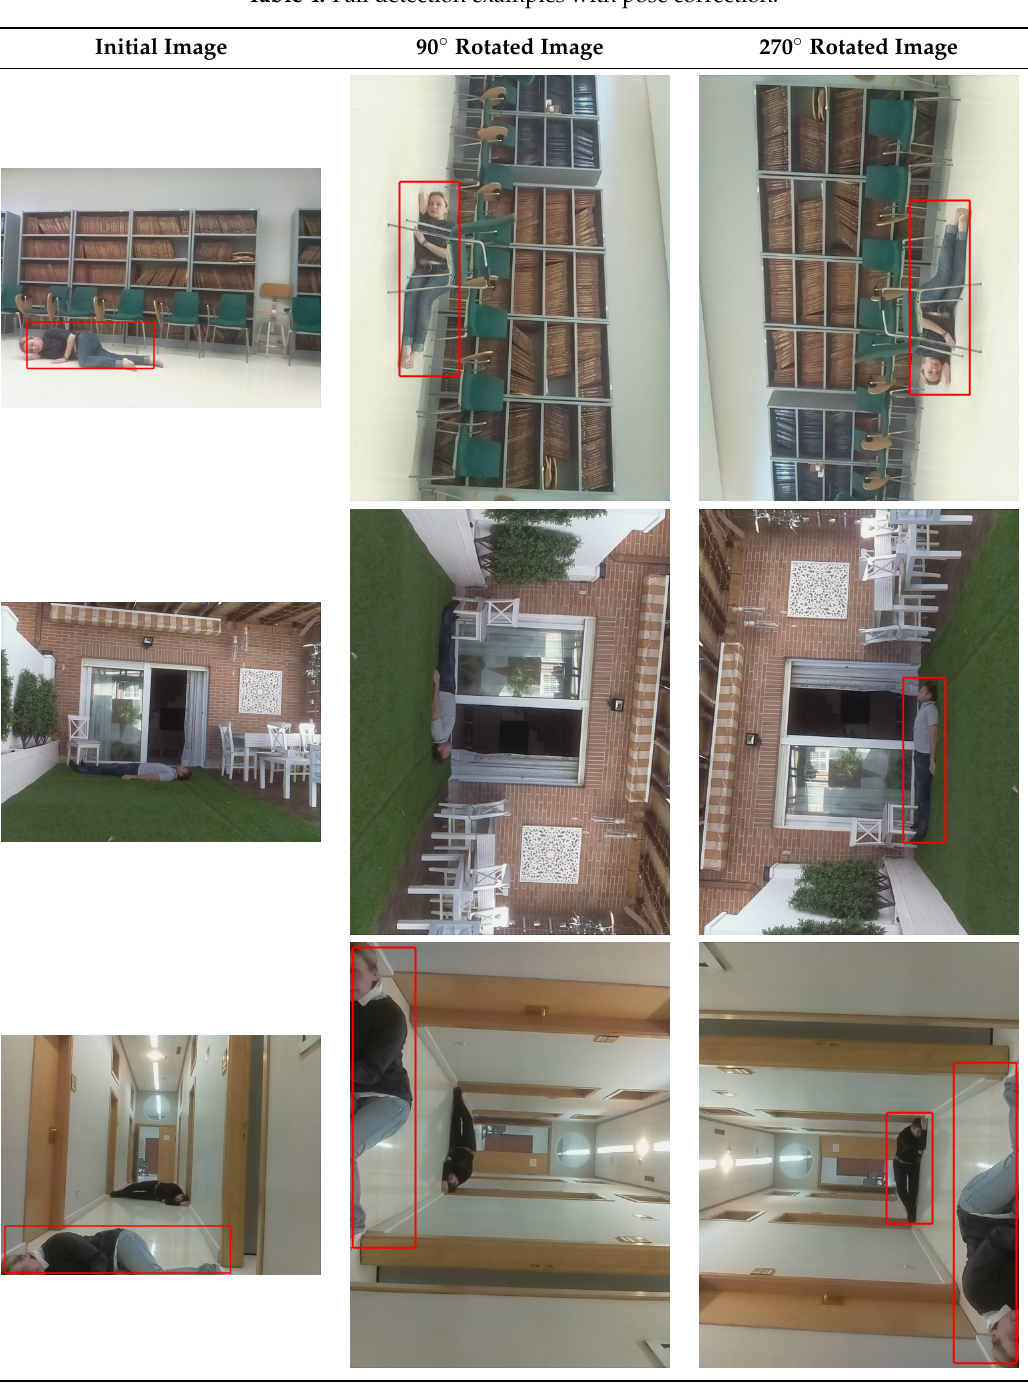
Table 4. Fall detection examples with pose